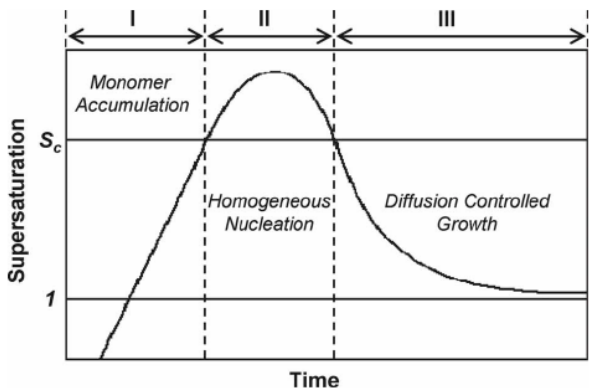
Figure 1. Nucleation and crystal growth. Reproduced with permission [31]. Copyright 1950, American Chemical Society.